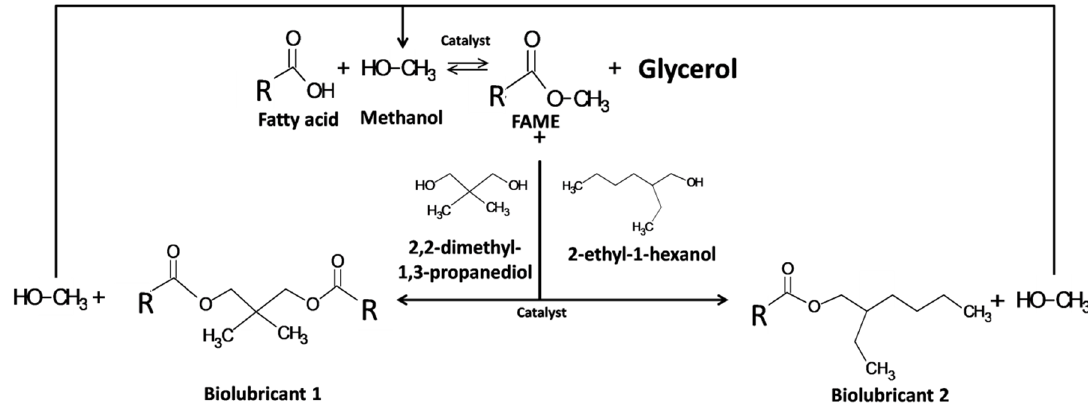
Figure 13. Possible chemical routes carried out in this experience to obtain two different kinds of biolubricants from cardoon through transesterification.